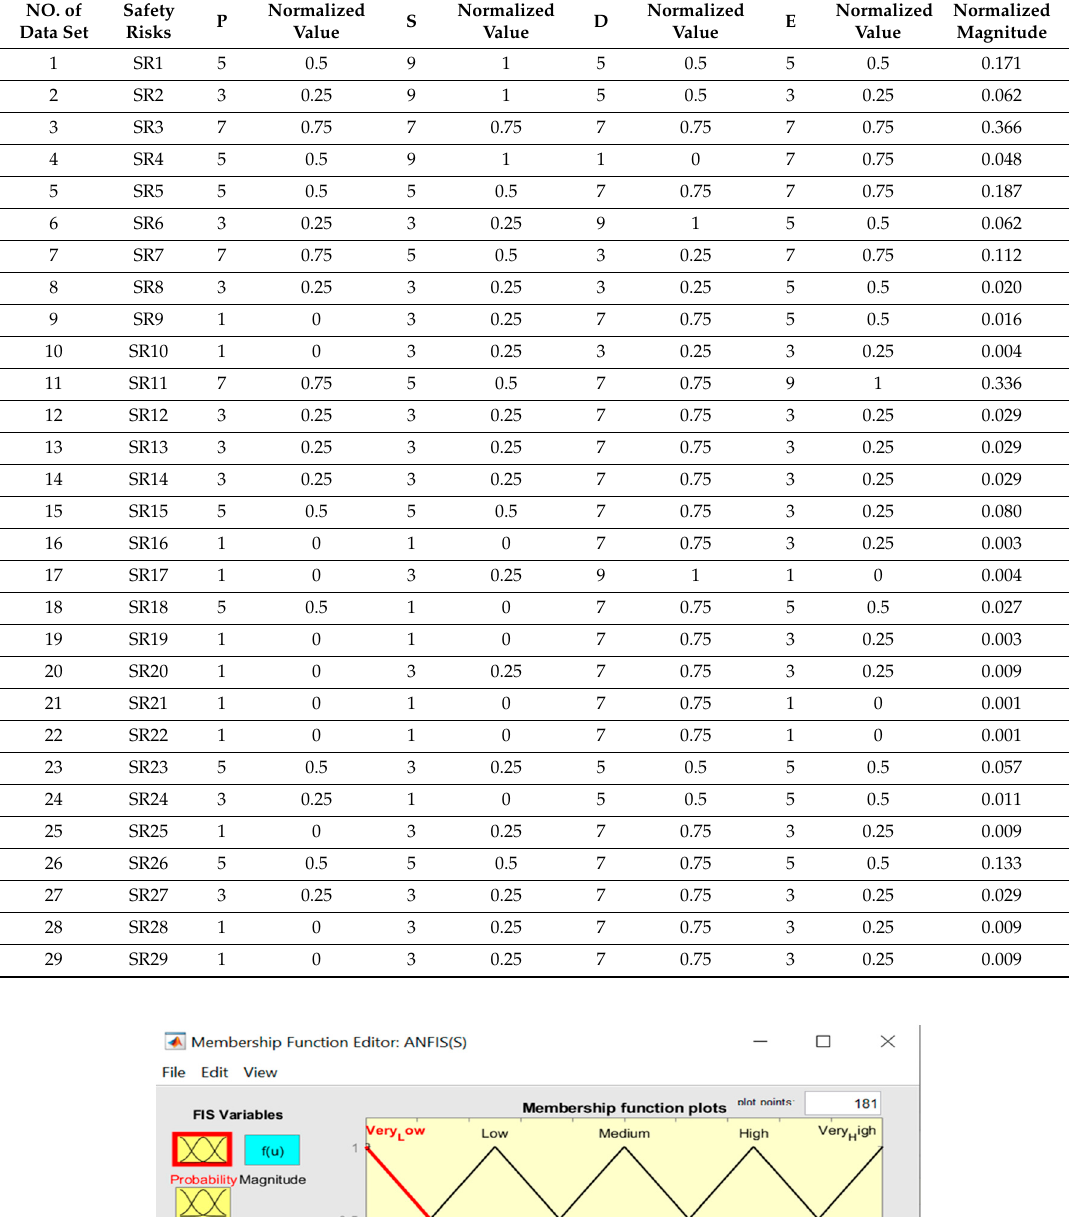
Table 8. Sample data set that is used for ANFIS input and output (29 input datasets out of total 203)